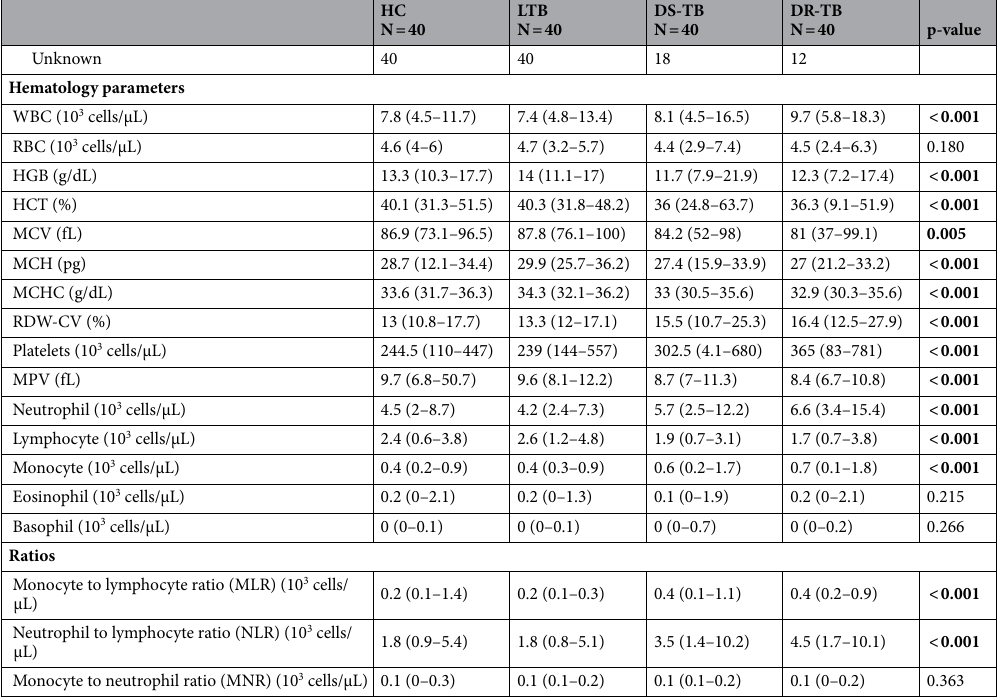
Table 1. Demographic characteristics. Values were presented as frequency (percentage) and median (range: minimum − maximum). Fishers exact test and Dunn test was used at 5% level of significance. The "Unknown" category was excluded while calculating the Fishers Exact test. Significant values are given in bold.